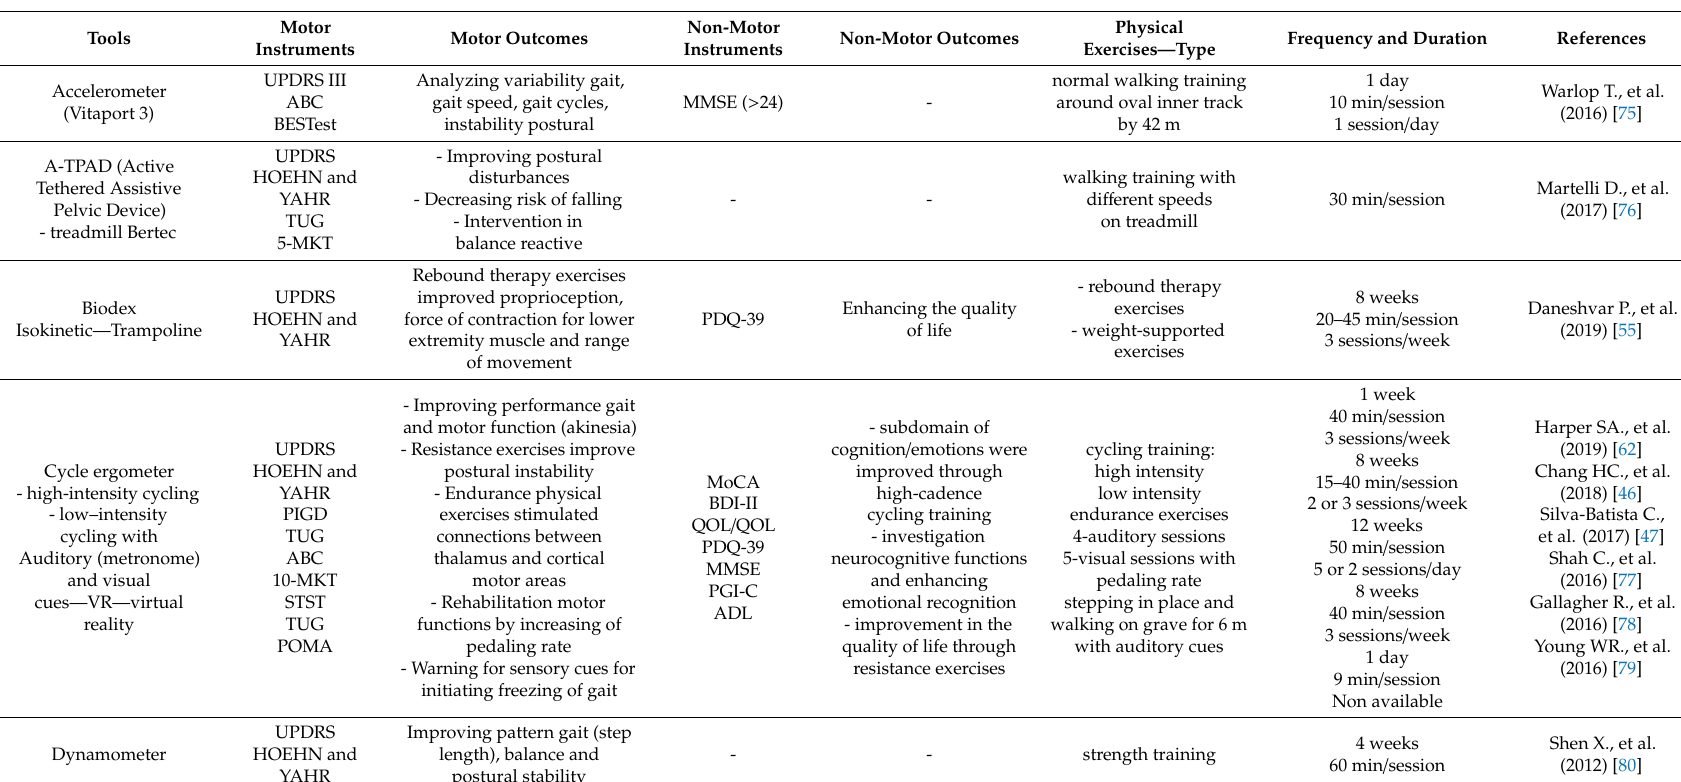
Table 2. Available Motor and Non-Motor